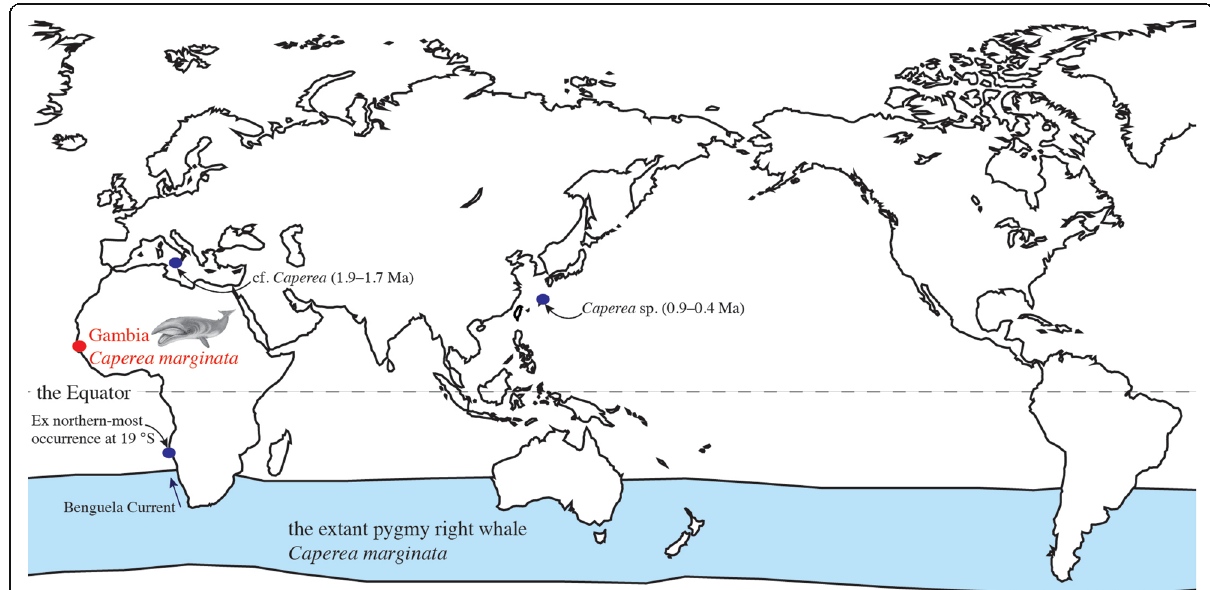
Fig. 2 Proposed distribution of the pygmy right whale (in light blue, modified from Kemper, 2014), extralimital occurrence at 19° S, Pleistocene occurrences in the Northern Hemisphere (blue circles; Ma: million years), and the occurrence of the Gambia Caperea (in red; Caperea illustration by Moyna